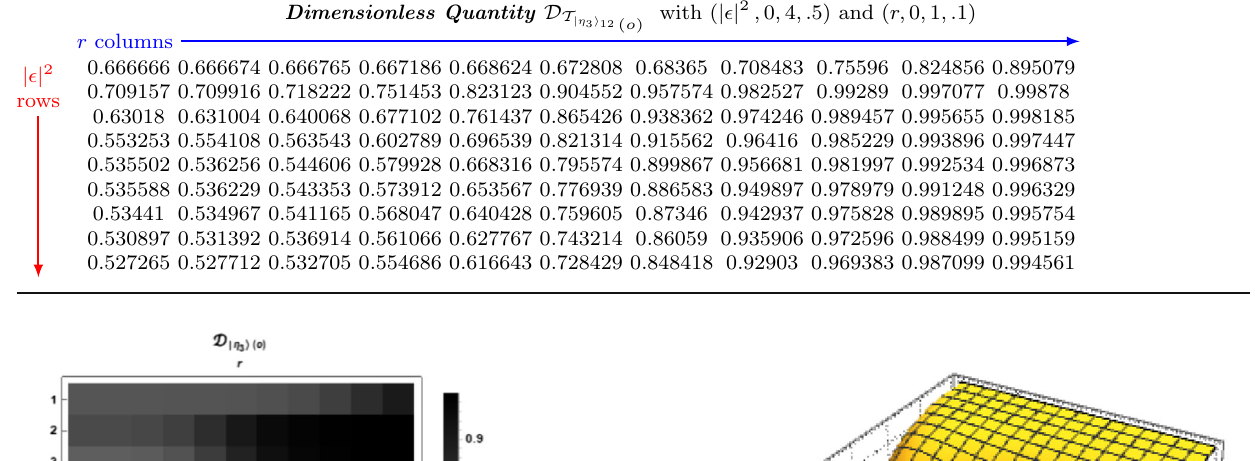
(a) Array Plot for the Table 11 showing numerical values of D T tabulated in the form of a | η 3 (cid:2) 12 ( o ) matrix for same range of coherent and squeezing parameters.